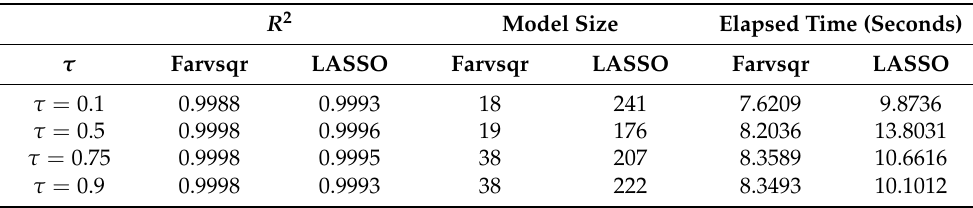
Table 15. The results of the real